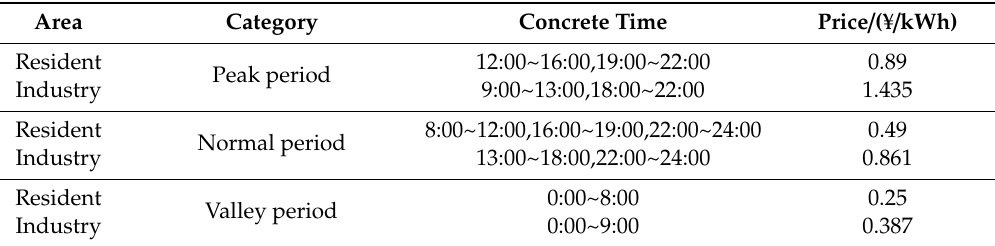
Table A1. Time-of-use electricity price.